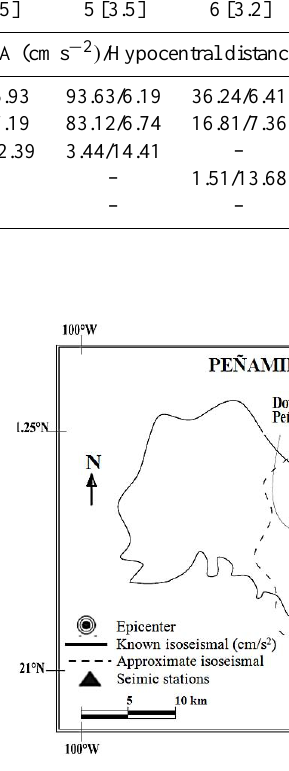
Fig. 8. Isoseismal of PGA amplitudes for the largest earthquake of M w = 3.5, seismic stations and downtown Peñamiller are